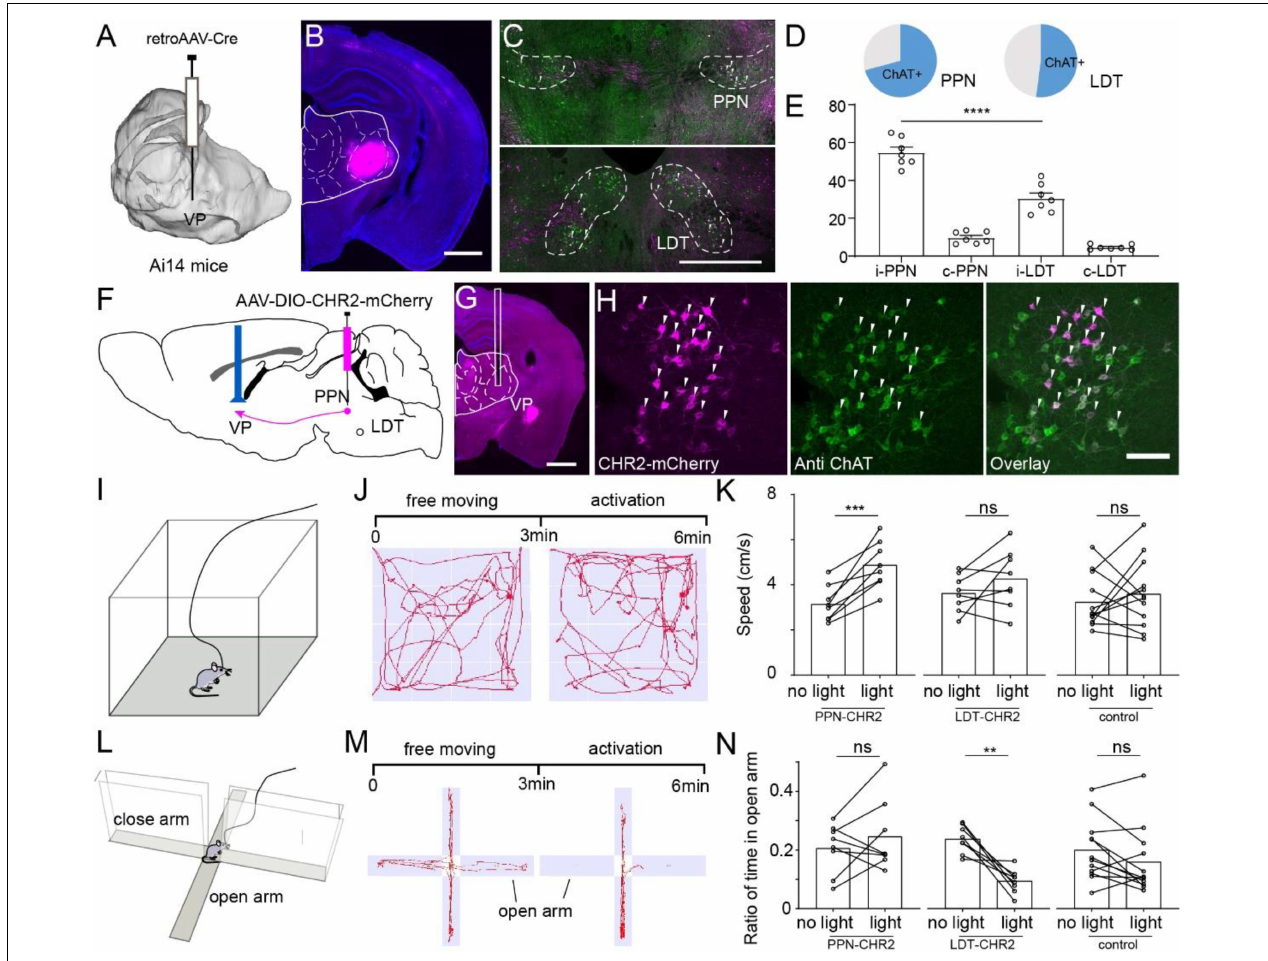
FIGURE 5 | Different roles of ChAT PPN and ChAT LDT projecting to VP. (A) Retro-AAV carrying Cre was performed in the VP of Ai14 reporter mice. (B) A typical coronal plane of an inject site. (C) Immunohistochemical staining of PPN or LDT neurons project to the VP. (D) Proportion of ChAT+ neurons projecting from PMT to VP. (E) Quantitative statistical proportion of ChAT+ neurons, originating from bilateral PPN and LDT. (F) Cre-dependent AAV virus expressing CHR2 and mCherry was injected in the PPN or LDT. (G) A typical coronal plane implanted with optical fiber. (H) Immunofluorescent staining of CHR2-labeled neurons. (I) A schematic diagram of mice in an open field. (J) The process of the experiment and typical motion trails of the mice moved in the open field. (K) Speed of the mice in the open field. (L) A schematic diagram of the mice in an elevated-plus maze. (M) The process of the experiment and typical motion trails of the mice moved in the elevated-plus maze. (N) The ratio of time that the mice spent in an open arm in the EPM. A scale bar, (B,G) 1,000 µ m; (C) 500 µ m; (H) 100 µ m. Data are shown as mean ± SEM. (E) Two-sided t -tests, (K,N) paired t -tests, ** p < 0.01, *** p < 0.001, **** p <